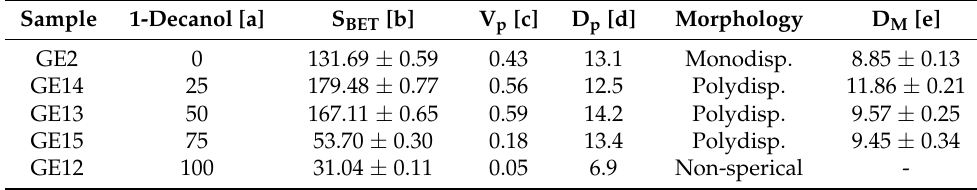
Table 5. Effect of cosolvency on morphology and porous structure.